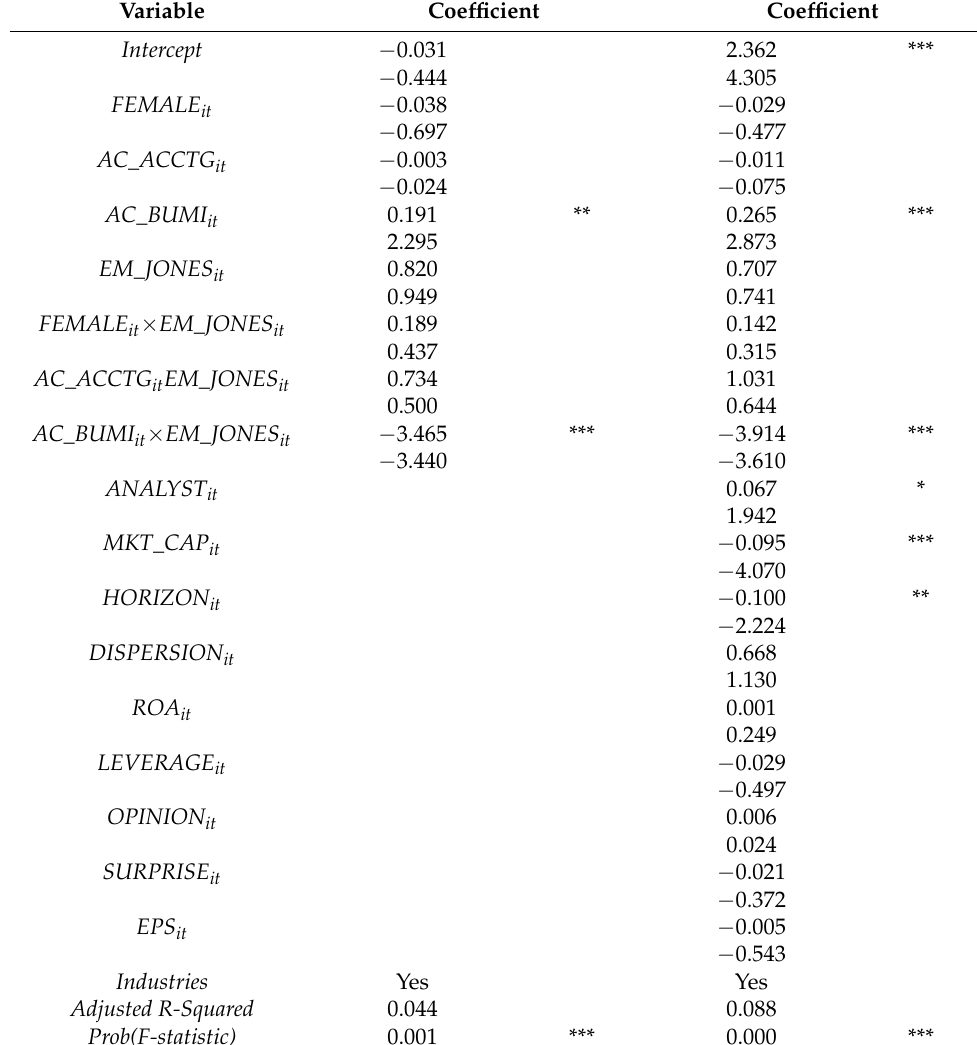
Table 9. Regression Analysis of Interaction between Audit Committee Diversity and Earnings Management with Analyst Forecast Accuracy Using Jones’ (1991) Model of Earnings